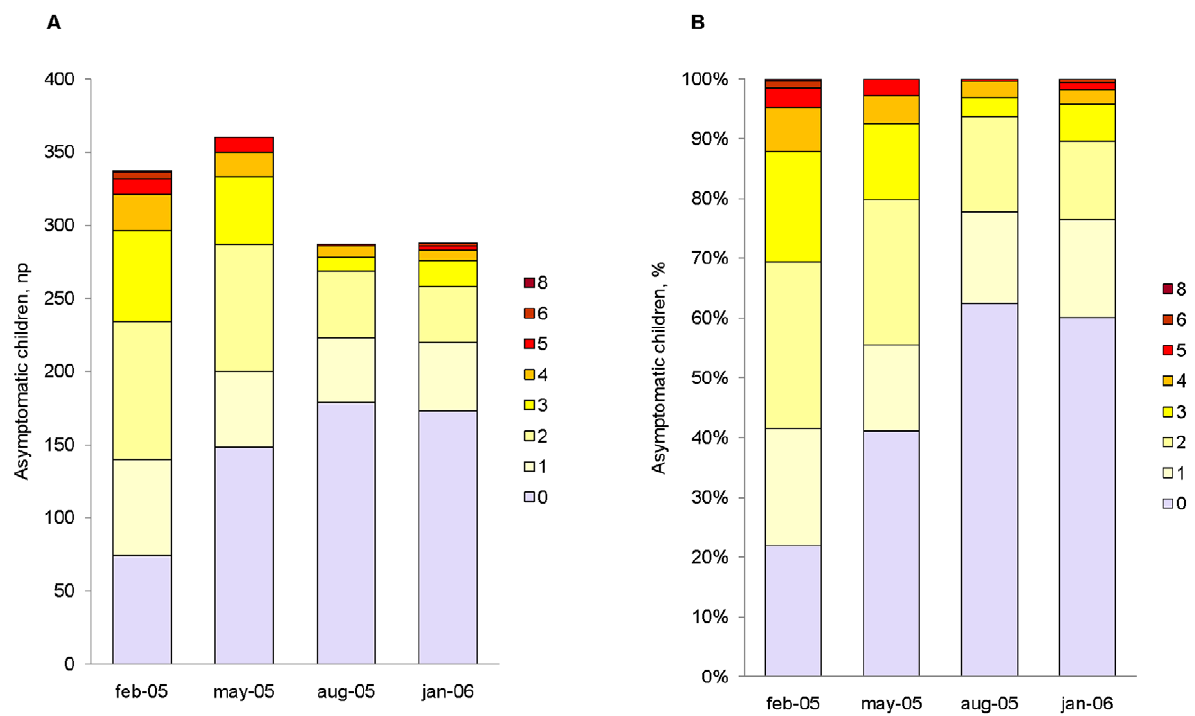
Figure 1. Number (A) and proportion (B) of asymptomatic children infected with different number of msp2 clones. doi:10.1371/journal.pone.0016940.g001 PLoS ONE |